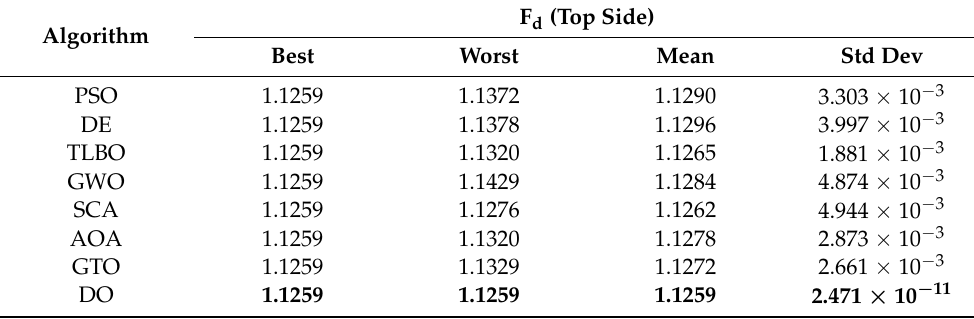
Table 4. Comparisons of nature-inspired algorithms in terms of delamination sizes at the top side. Algorithm